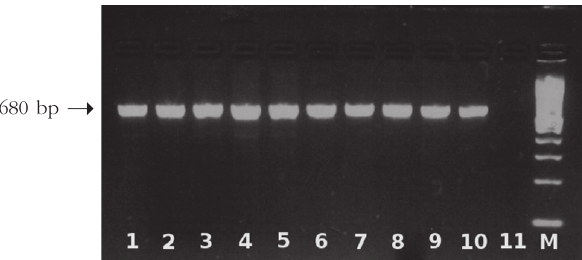
Fig. 1. – Agarose gel electrophoresis of amplified ITS1 ribosomal region. Lanes 1-10 denote to different fluke samples amplified as a single band of 680 bp; lane 11, negative control; lane M, 100 bp ladder molecular weight marker.